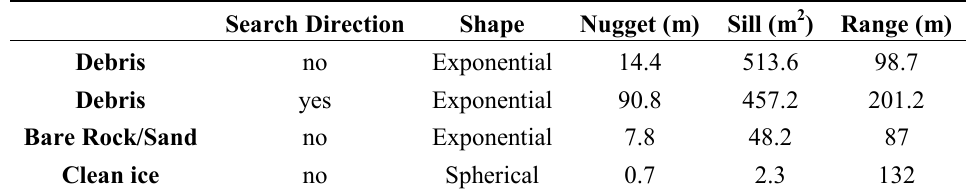
Table 5. Variogram characteristics of the three types of surfaces extracted from PC1 and three regions of interest (ROIs).